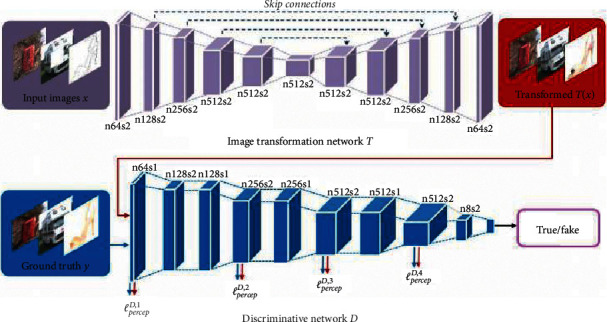
PAN network structure [40].